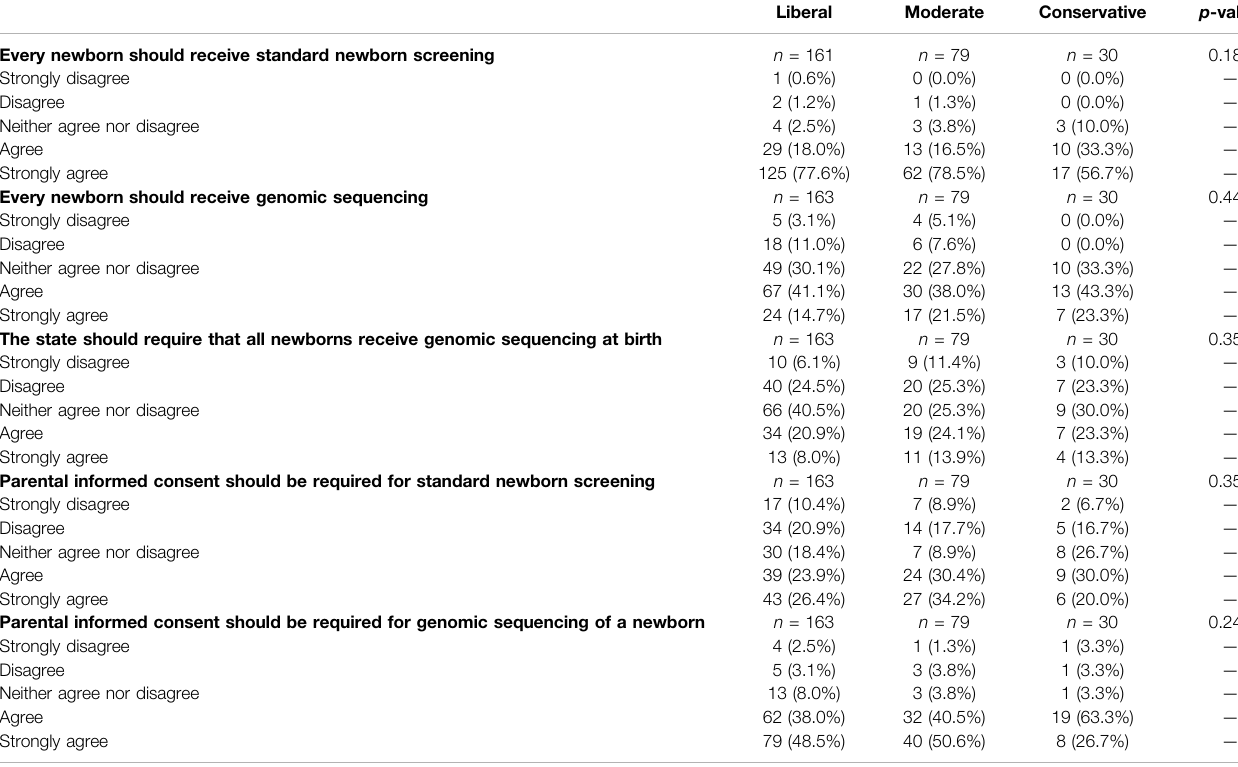
TABLE 3 | Parents ’ attitudes regarding newborn screening and genomic sequencing by political orientation.